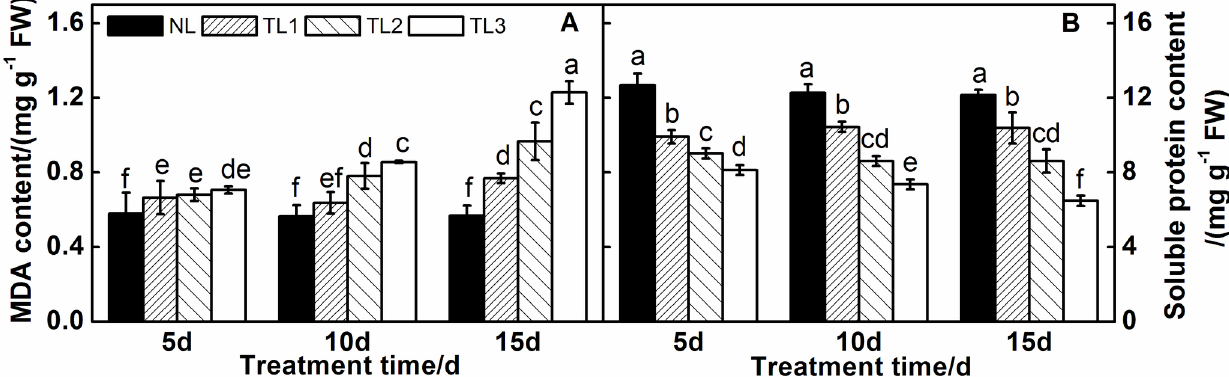
Fig 4. Effects of low light treatment on the MDA (A) content and the solubleprotein (B) content in leaves of purplepak-choi seedlings. The data are the mean of three replicates, with SDs shown as vertical bars . The means marked with different letters indicate significantdifferences betweentreatments at p < 0.05,as determinedwith Duncan’smultiplerange test. Different lower-caseletters at each time point indicate significantdifferencesbetweentreatments. FW is the abbreviation of fresh weight.